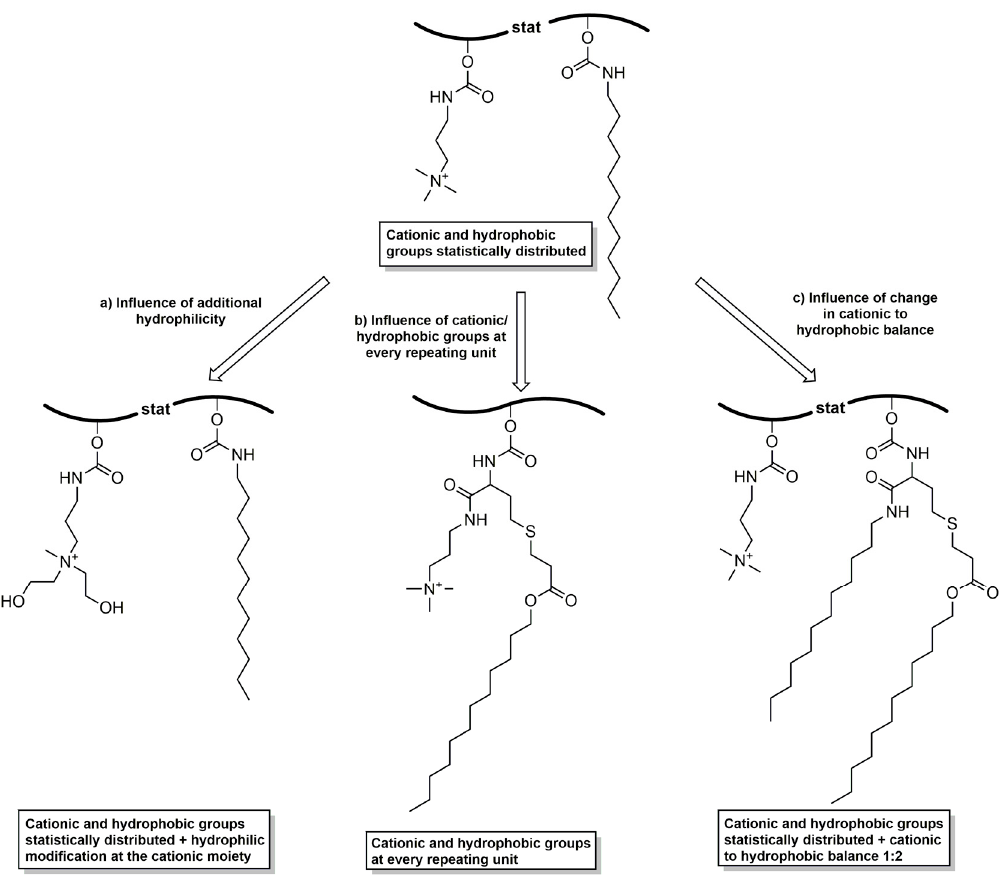
Figure 1. Comparison of various cationic–hydrophobic functionalized polyglycidols in regard to their antibacterial activity against E. coli and S. aureus to examine the structure–property relationship.